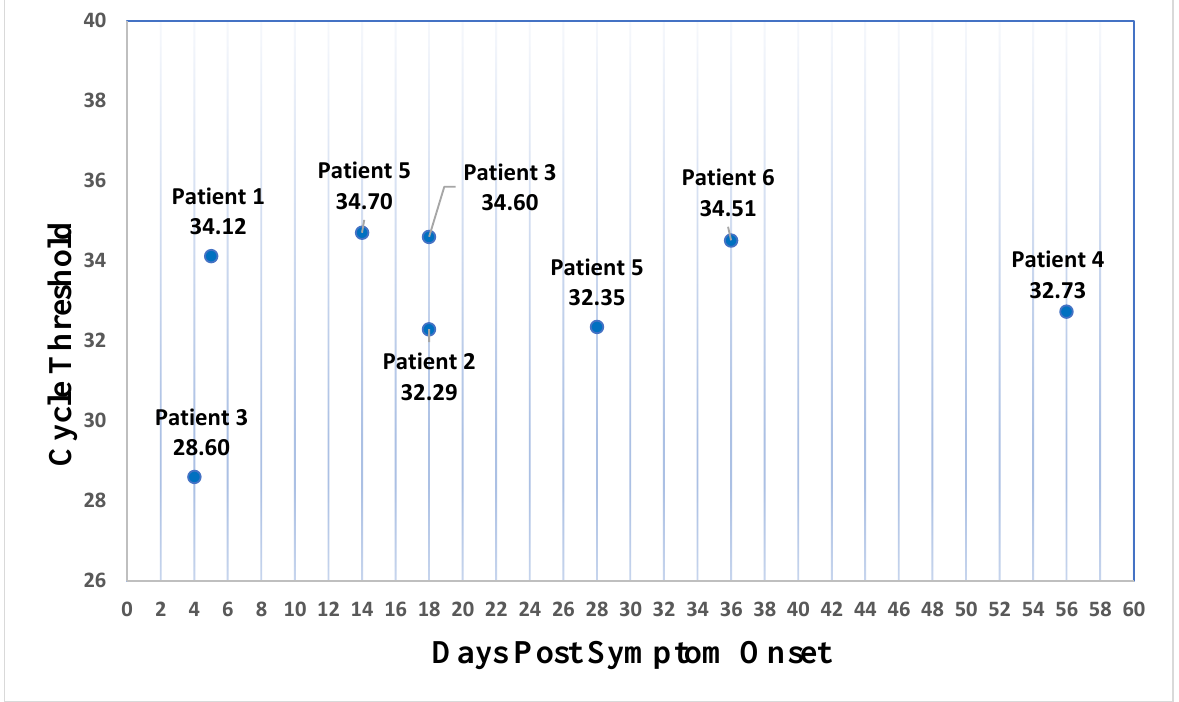
Figure 1. CHIKV cycle threshold by days after the onset of symptoms in semen.